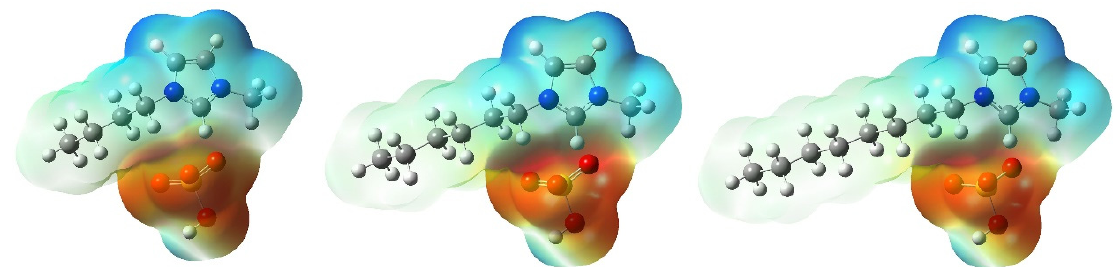
Figure 4. Electrostatic potential (ESP) maps for the studied ILs fromB3LYP/6-31++G(d,p).